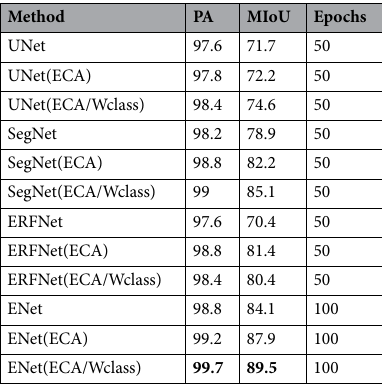
Table 1. Comparison of different improvements in the course of ablation experiments. Significant values are in